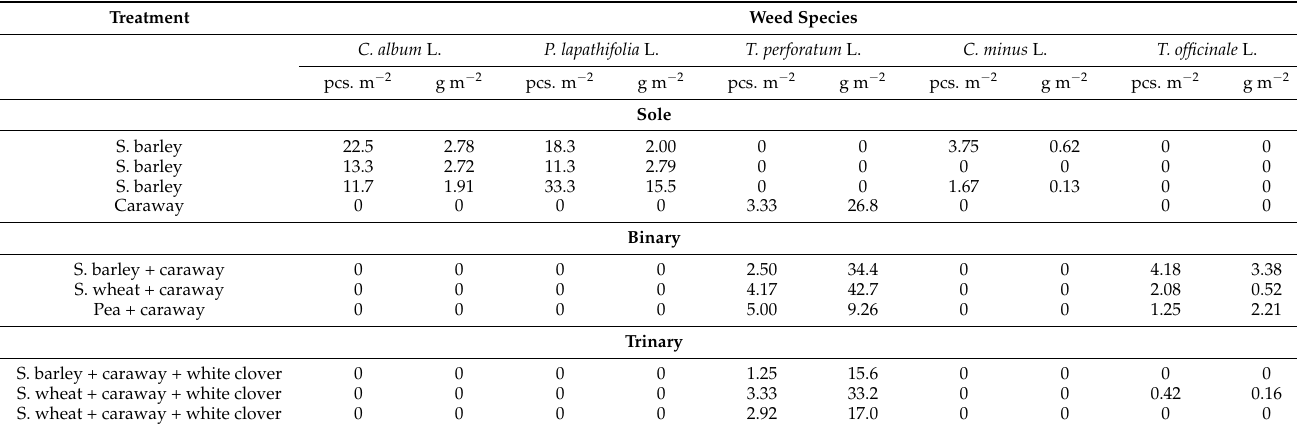
Table 3. The average number and the average biomass of dominant weed species in sole, binary, and trinary crops in 2018. Treatment Weed